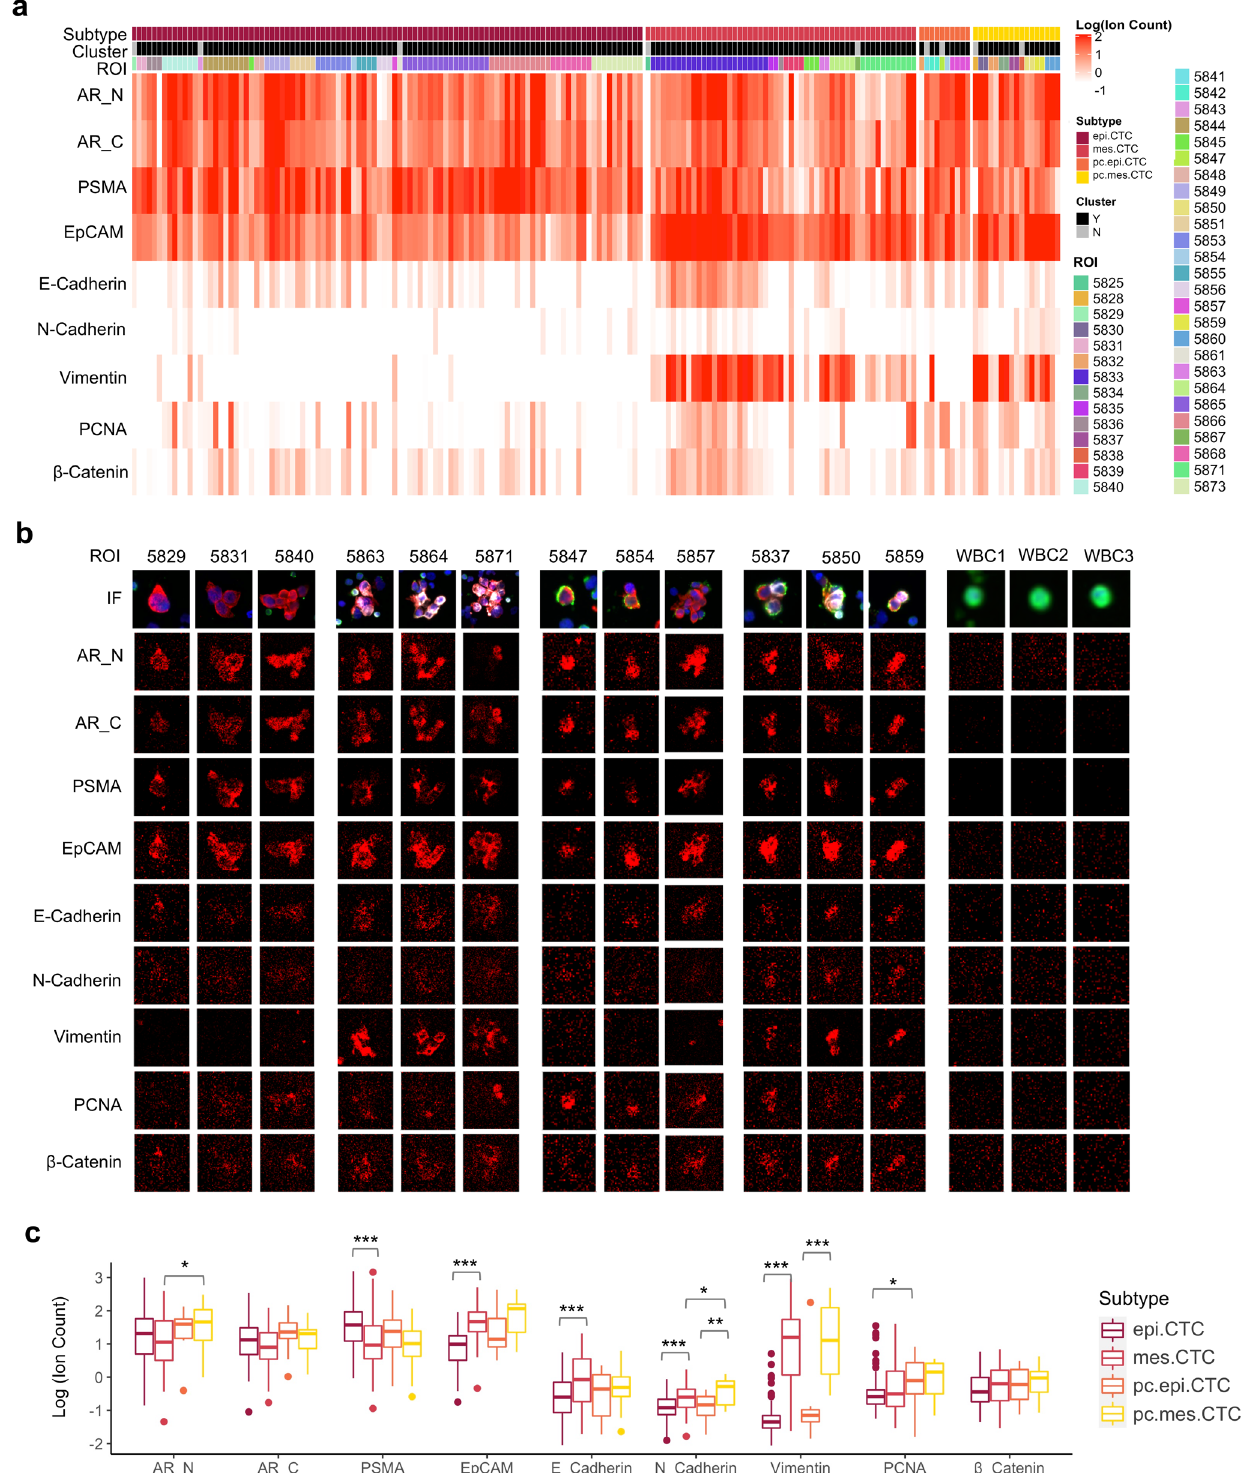
Fig. 5 Targeted proteomics of CTC subtypes. a Heatmap of proteomic expression in CTC subtypes, including AR-N terminal (AR_N), AR-C terminal (AR_C), PSMA, EpCAM, E-Cadherin, N-Cadherin, Vimentin (VIM), PCNA, and β -catenin. b Immuno fl uorescence and image mass cytometry images of representative CTC subtypes. c Comparisons of proteomic expressions among CTC subtypes. Center line of box: median; upper/lower hinges of box: 75% or 25% quartile; upper/lower whiskers of box: hinge ± 1.5*IQR (inter-quartile range). * p < 0.05, ** p < 0.01, *** p <